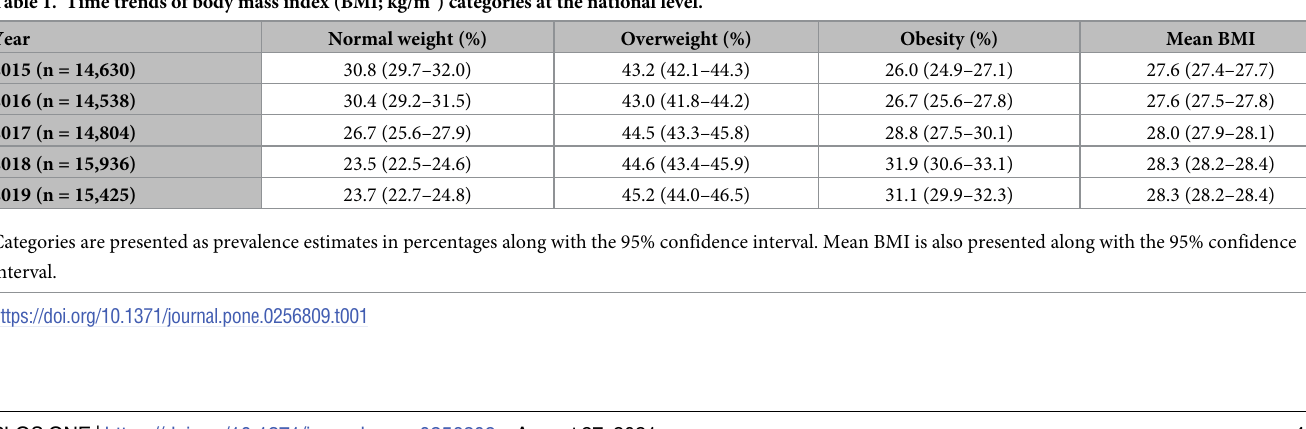
Table 1. Time trends of body mass index (BMI; kg/m 2 ) categories at the national level. Year